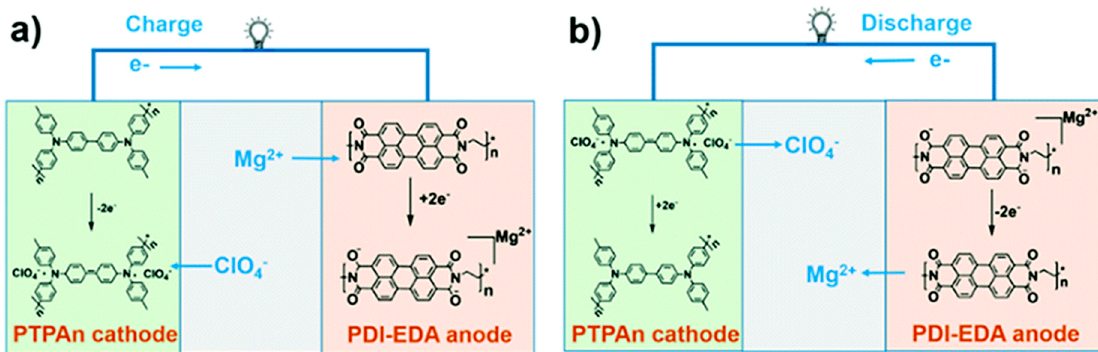
Figure 7. Illustration of the working mechanism of a Mg-ion battery based on perylene diimideethylene diamine (PDI-EDA) and polytriphenylamine (PTPAn) showing the charging process ( a ) and the discharging process ( b ). (From reference [83] with permission.).